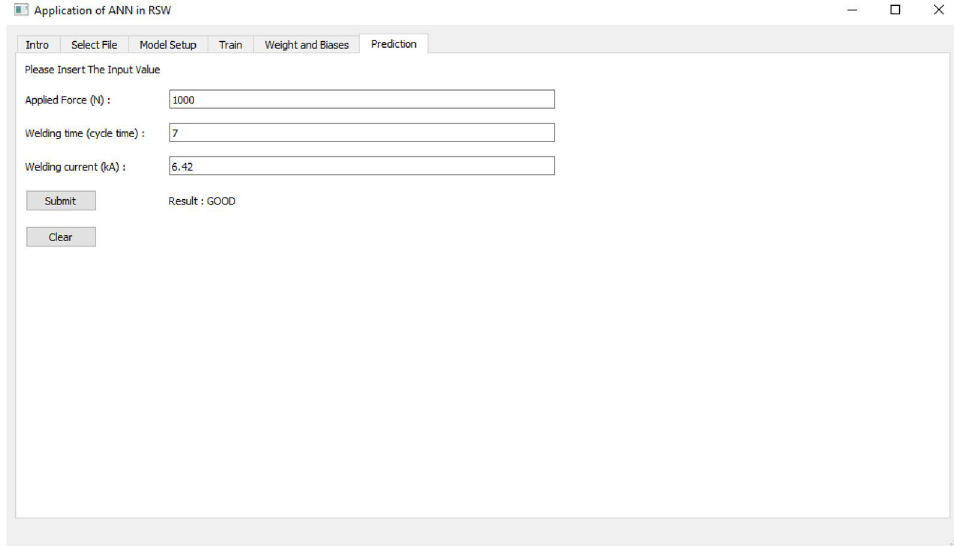
Figure 12. Prediction section as Tab 6.